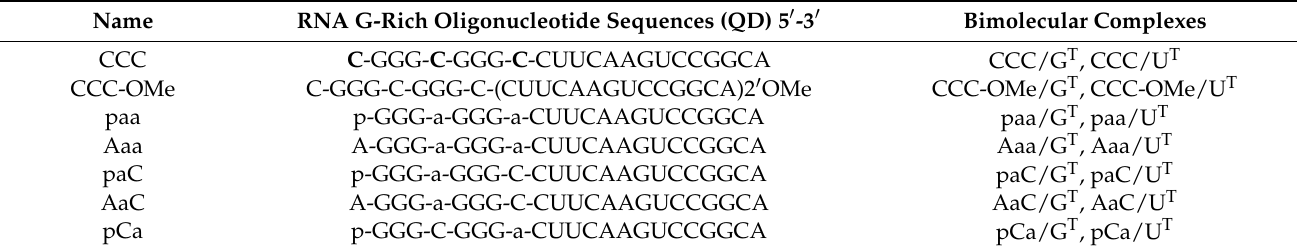
Table 1. List of RNA and DNA Sequences (5 ′ → 3 ′ ) Analyzed in This Work. Name RNA G-Rich Oligonucleotide Sequences (QD) 5 ′ -3 ′